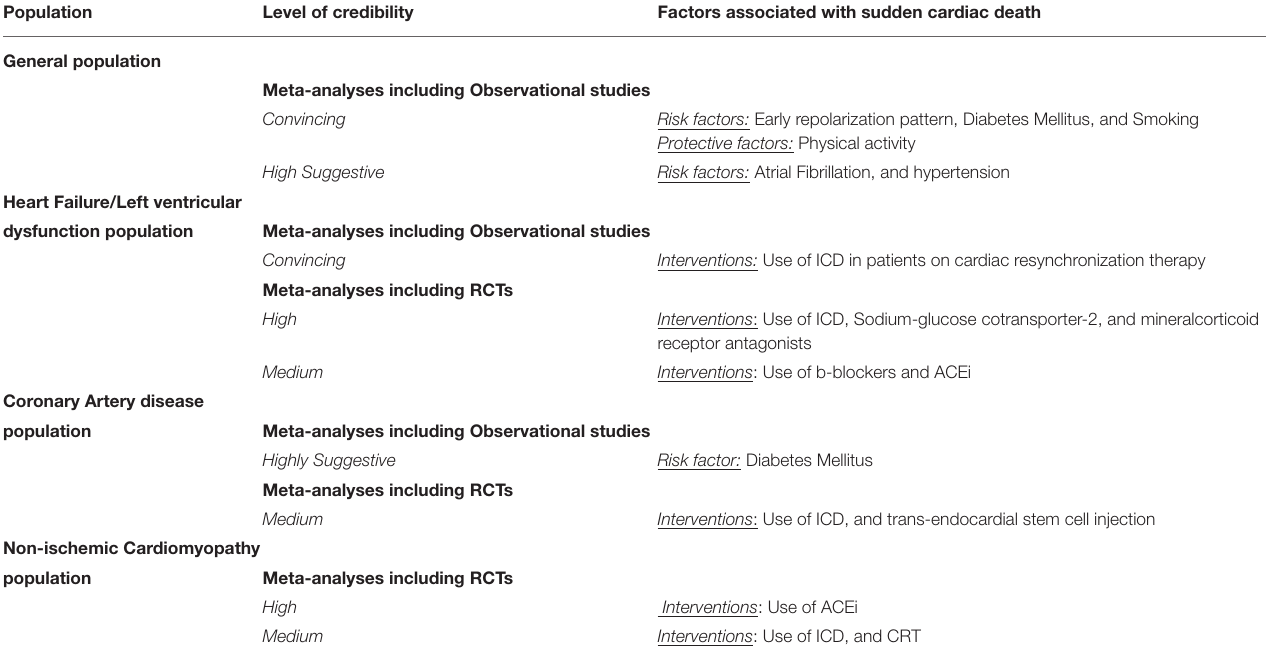
TABLE 3 | A summary of associations with high epidemiological credibility of risk and protective factors with the risk of postoperative atrial